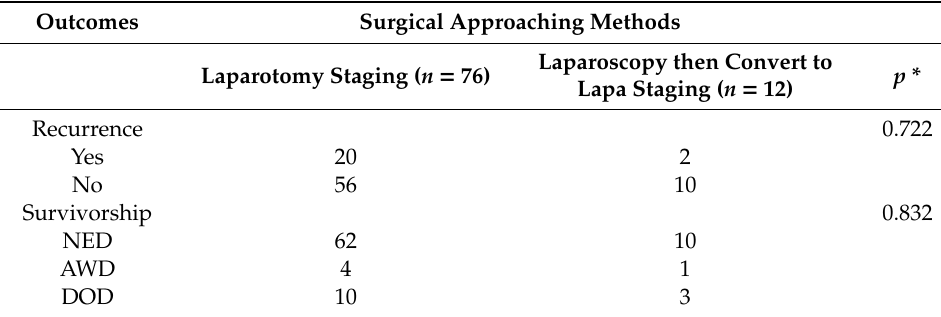
Table 3. Survivorship analysis between surgical approaches.